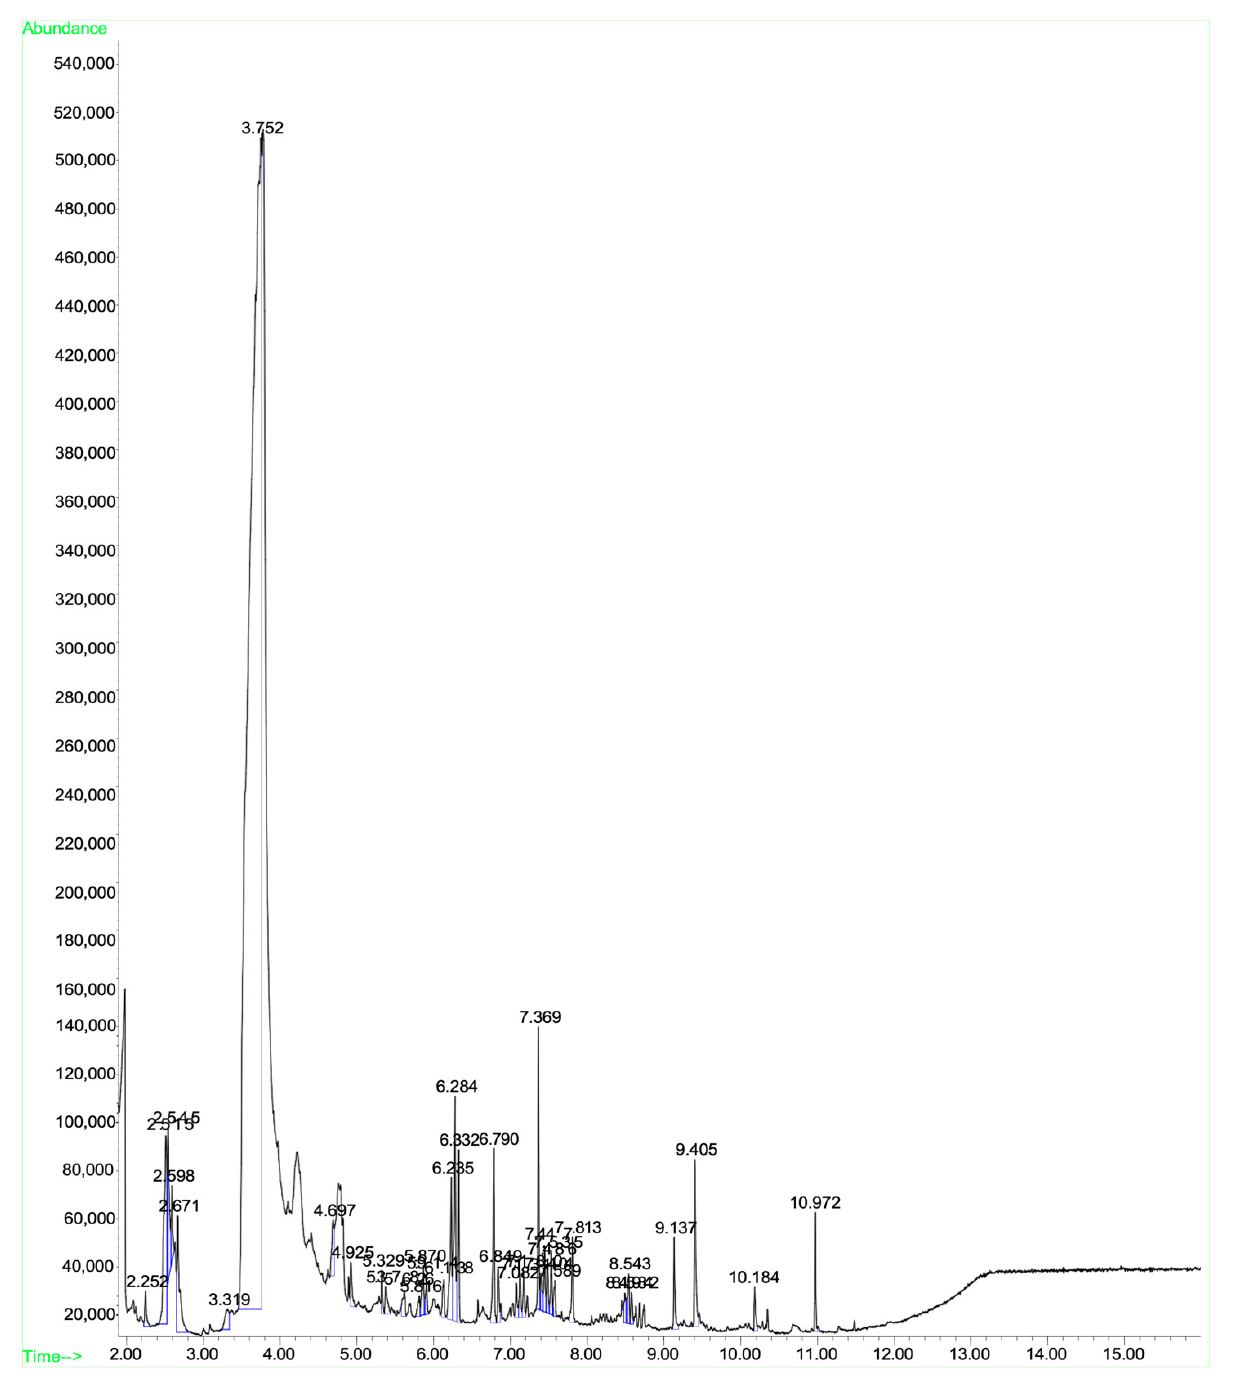
Figure 3. GC-MS spectrum of the semivolatile organic compounds present in KH.